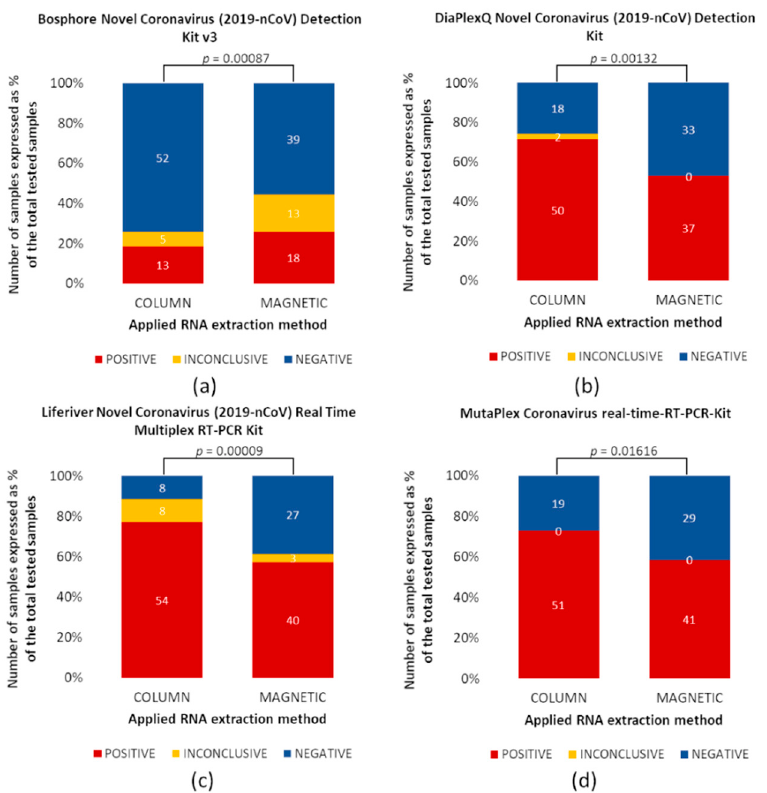
Figure 3. Comparison of two RNA extraction methods. RNA was extracted using two methods, column- (left) and magnetic-based (right). All samples were analyzed using four different RT-PCR kits identified SARS-CoV-2, ( a ) Bosphore, ( b ) DiaPlexQ, ( c ) Liferiver, and ( d ) MutapPex. Graphs present the % of positive (red), inconclusive (orange), and negative (blue) samples with a total of 70 samples. Samples for which SARS-CoV-2 RNA was not detected are marked as 0. Comparisons for paired nominal data were performed using chi-square McNemar’s Marginal Homogeneity Test. A p -value < 0.05 is statistically